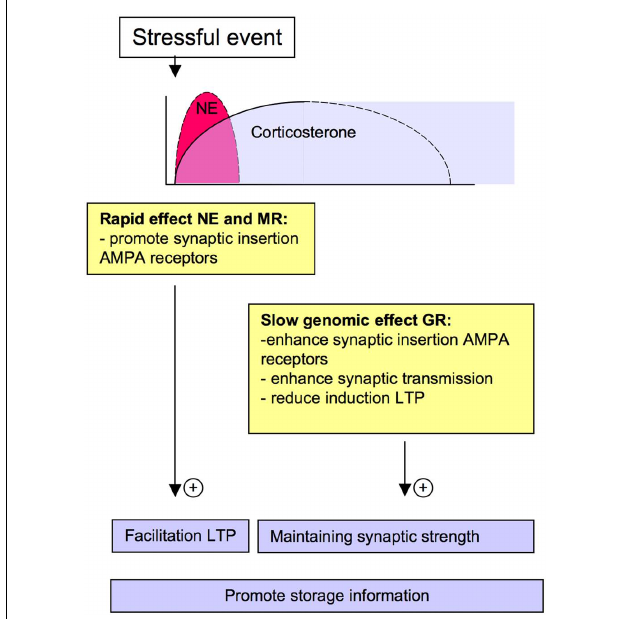
FIGURE 1 | Norepinephrine and glucocorticoids rapidly increase activity-dependent synaptic insertion ofAMPA receptors. Slowly, corticosteroid hormones enhance AMPA receptor mediated synaptic transmission and reduce the ability to encode novel information.This might preserve and promote the retention of the original (fearful and relevant) memory trace (see text for